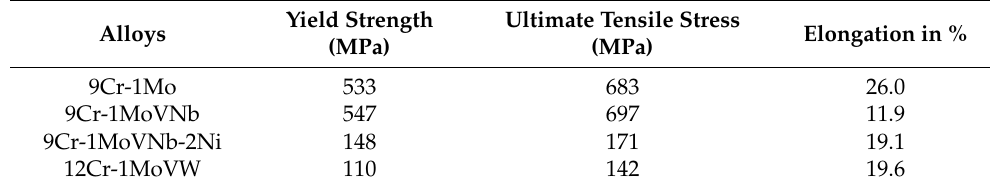
Table 6. Mechanical characteristics of martensitic alloys, reprinted with permission from refs. [43–45].